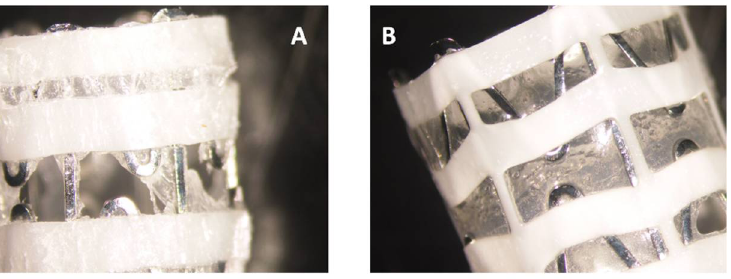
Figure 1. ( A ) SRV-CHX-coated stent in closed state. ( B ) The coating after opening the stent.